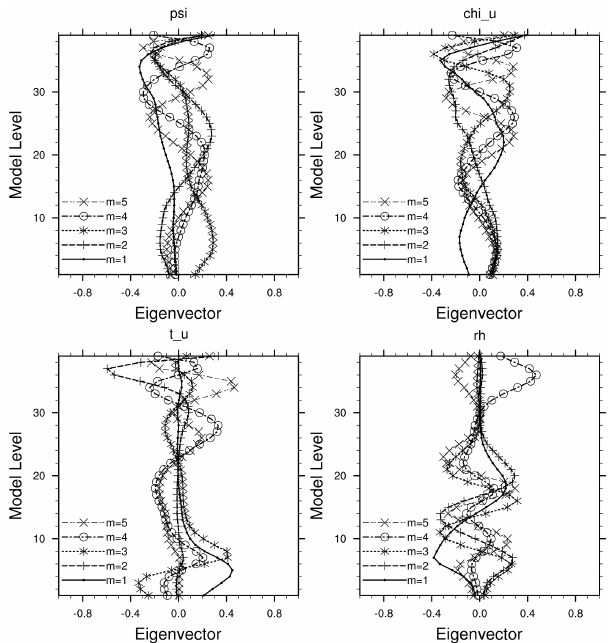
Figure 6. Representation of the first five eigenvectors resulting from the EOF decomposition of the vertical autocovariance matrix, eigenvectors of (a) psi, (b) chi u , (c) t u , and (d) RH. The eigenvec- tors are parameters that define the vertical transform ( U v ) ; (WRF, res. 15km, D-ensemble,